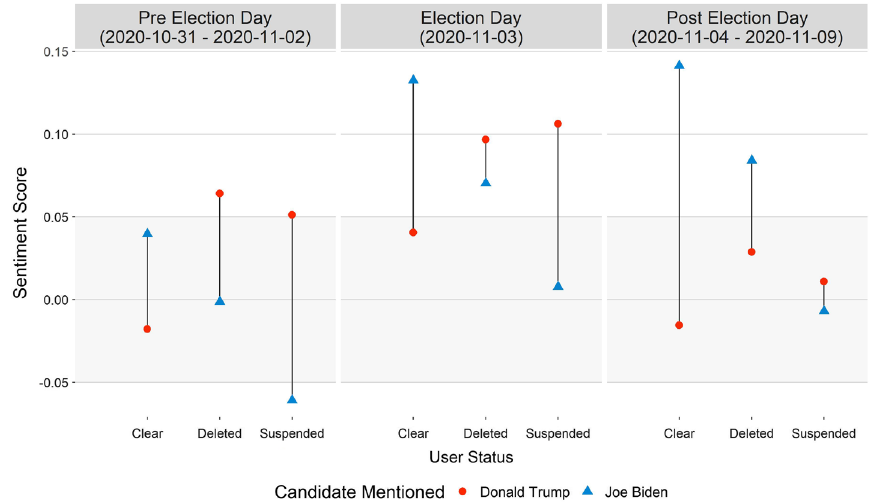
Fig. 5 Average sentiment scores of tweets that mentioned either candidate grouped by user status type, before, during, and after Election Day. For each user status type, a straight line is drawn to highlight the difference between the sentiment scores for each candidate. They gray shaded region in the plots represents the neutral sentiment area. Tweets that mentioned both candidates are